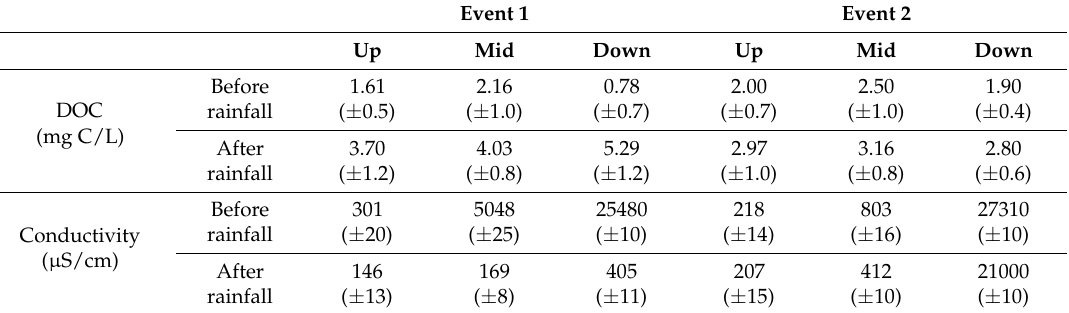
Table 4. Water characteristics of sampling points (n =